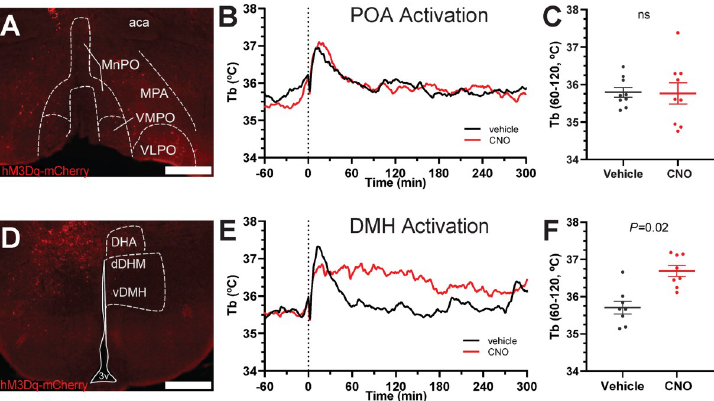
Fig 7. Chemogenetic activation of DMH Adora1 , but not POA Adora1 neurons increases Tb. A-C tests activation of the POA. (A) Example of hM3Dq-mCherry expression in Adora1-Cre mouse injected with AAV8-hSyn-DIO-hM3Dq- mCherry in the POA. (B) Tb response to CNO (1 mg/kg, i.p.) vs. vehicle in Adora1-Cre mice with hM3Dq-mCherry in POA (n = 11). (C) Mean Tb at 60 to 120 minutes after dosing with CNO (1 mg/kg, i.p.) vs. vehicle. D-F tests activation of the DMH. (D) Example of hM3Dq-mCherry expression in Adora1-Cre mouse injected with AAV8-hSyn-DIO- hM3Dq-mCherry in the DMH. (E) Tb response to CNO (1 mg/kg, i.p.) vs. vehicle in Adora1-Cre mice with hM3Dq- mCherry in DMH (n = 8). (F) Mean Tb at 60 to 120 minutes after dosing with CNO (1 mg/kg, i.p.) vs. vehicle (n = 8). Data are mean ± SEM (SEM is omitted for visual clarity in B and E). P values were calculated by paired t -test comparing drug vs vehicle within mouse. Scale bar is 500 μ m. aca, anterior commissure; dDMH, dorsomedial hypothalamus, dorsal part; DHA, dorsal hypothalamic area; MnPO, median preoptic area; MPA, medial preoptic area; vDMH, dorsomedial hypothalamus, ventral part; VMPO, ventromedial preoptic area; VLPO, ventrolateral preoptic area.